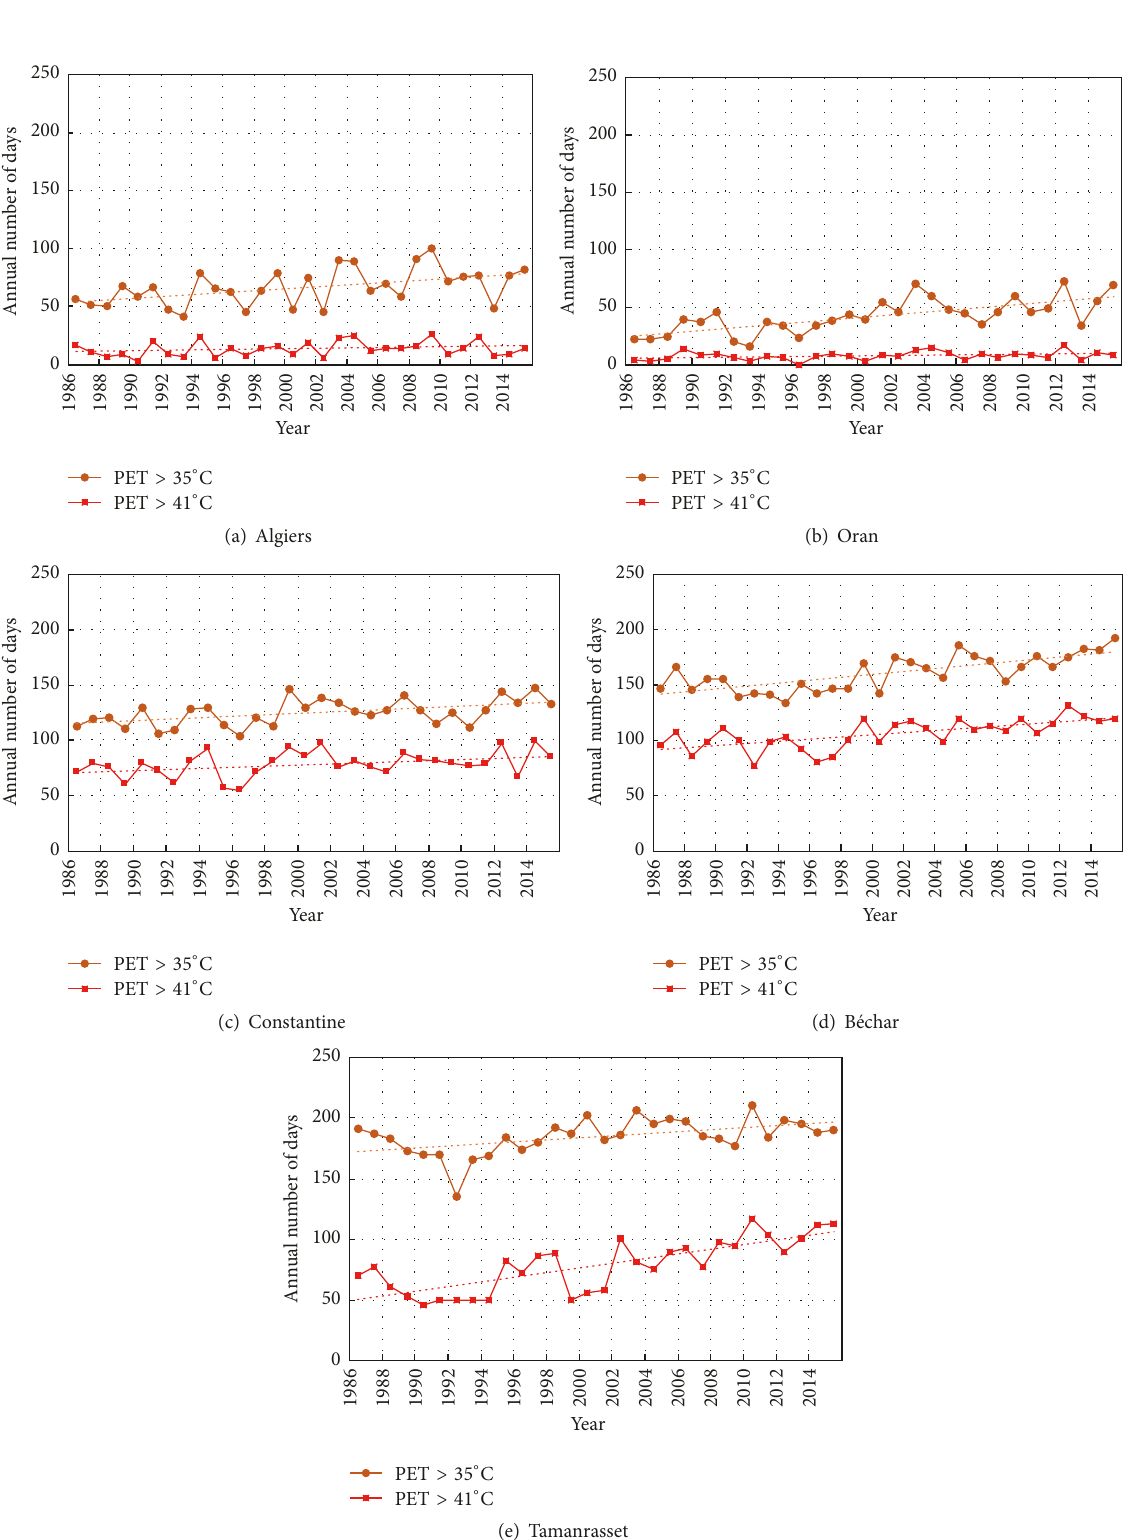
Figure 4: Evolution of the annual number of days in each city (solid lines) with PET > 35 ∘ C and PET > 41 ∘ C for the period of 1986–2015 associated with their respective linear trend lines